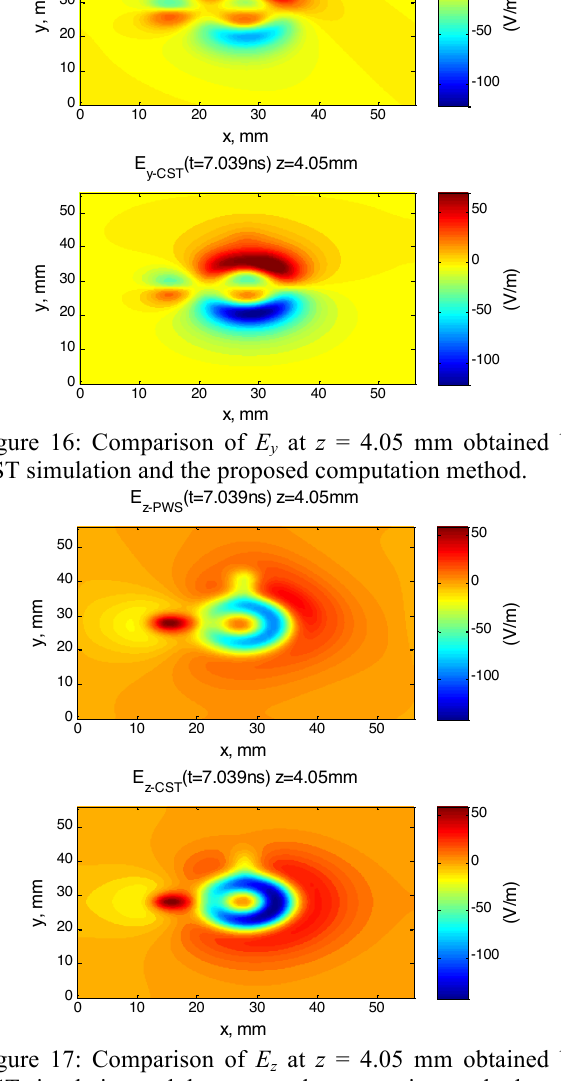
at z = 4.05 mm obtained by z